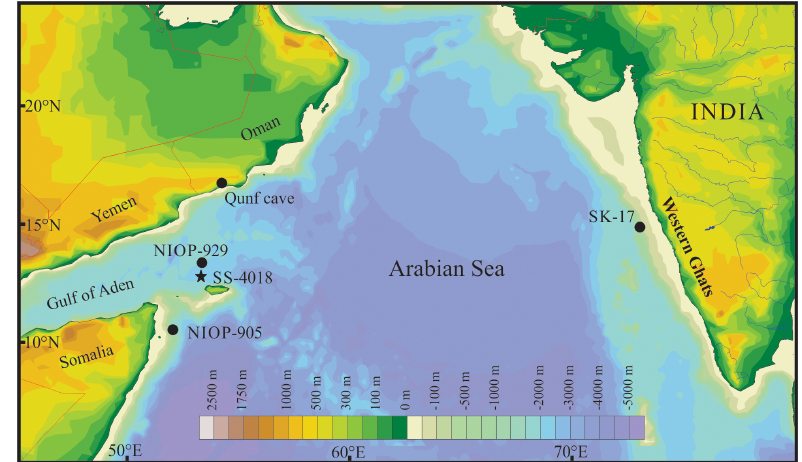
Figure 2. Location of the SS-4018 sediment core (filled star) in the Arabian Sea. The other sites discussed in the paper are also shown: NIOP-929 (Saher et al., 2007), NIOP-905 (Huguet et al., 2006), SK-17 (Anand et al., 2008) and Qunf Cave (Fleitmann et al., 2007). Map drawn with Ocean Data View (Schlitzer,